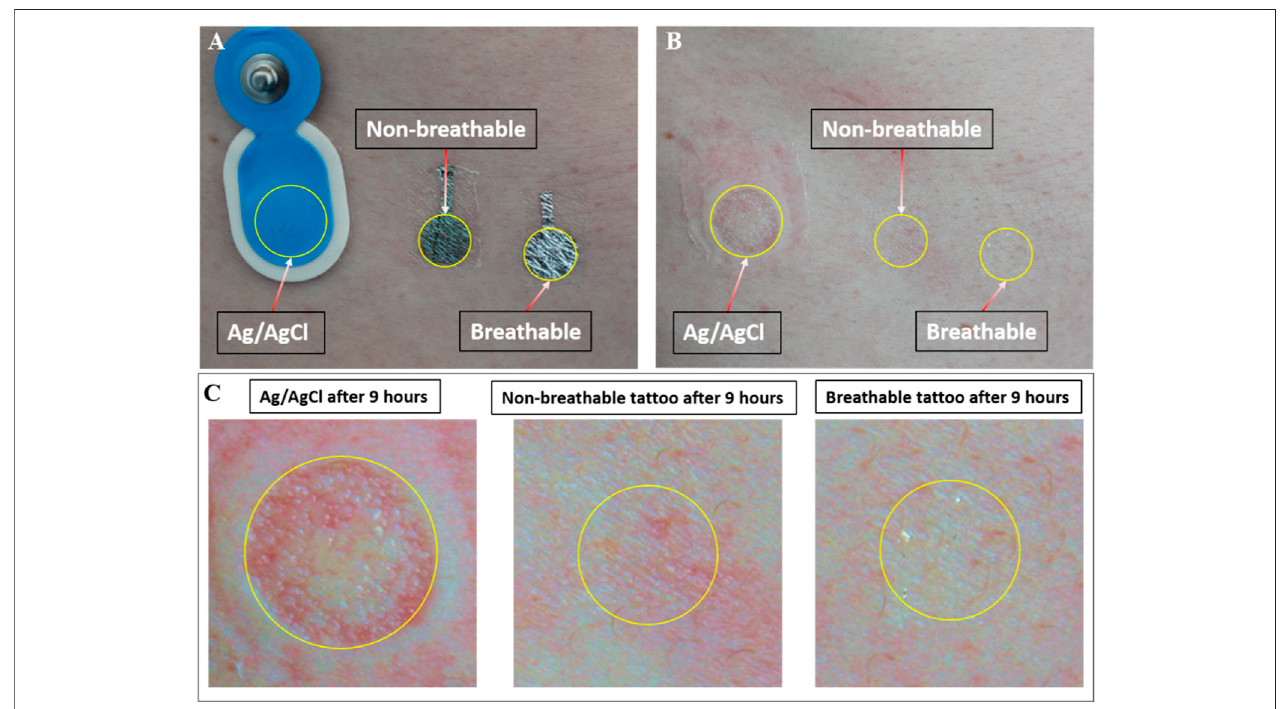
FIGURE11| Effect ofthe electrodes on theskin. (A) Thethree types ofelectrodes placedon theright hip ofthesubject. (B) Thesamespotafter theremoval ofthe electrodes (9 h). (C) Magni fi cation of the same area. Worse skin irritation was induced by the commercial electrode with respect to the Parylene C electrodes.